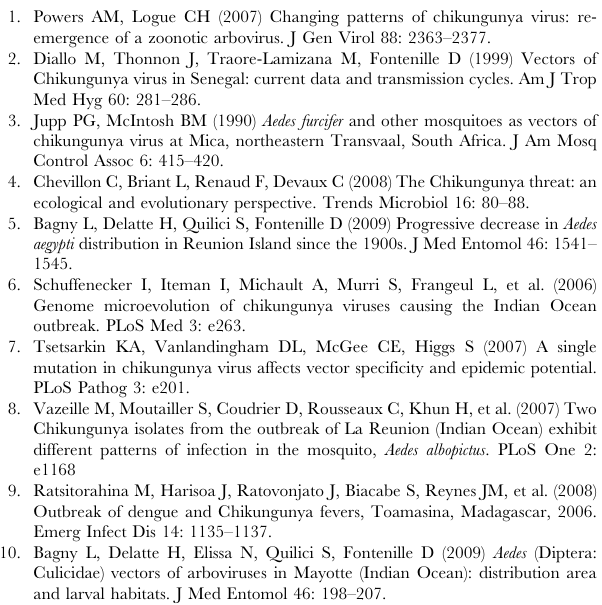
Figure S1 Histological localization of CHIKV in Ae. aegypti (AAPT) and Ae. albopictus (ALPROV). Mosquitoes